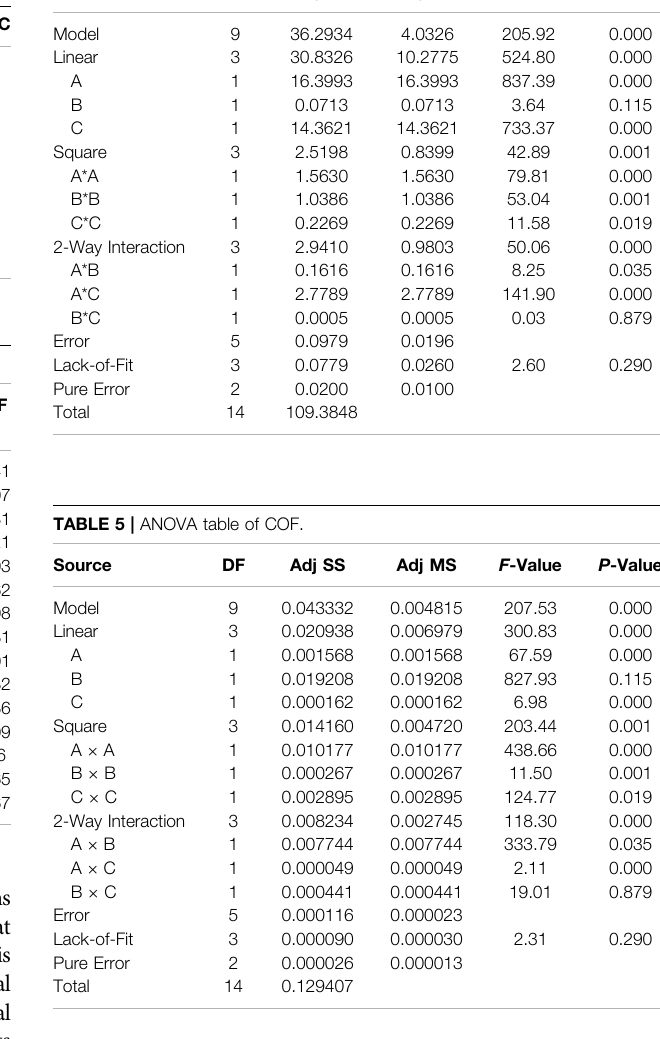
TABLE 2 | Compositional details of fabricated nanocomposites. Element